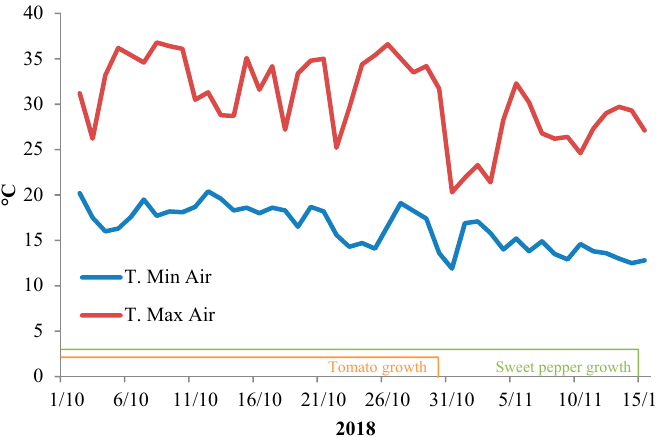
Figure 1. Daily average maximum and minimum temperatures of the air inside the greenhouse during nursery trials.